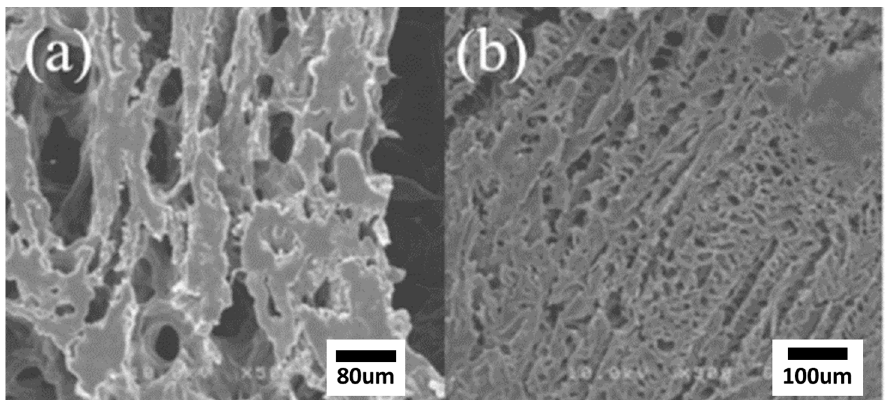
Figure 4. SEM of the edge of tablets removed from dissolution media (pH 6.8 phosphate buffer) after 1 h ( a ) Tablet with HPMC HME 4M ( b ) Tablet with HPC GXF. Tablet obtained after melt granulation of metformin HCl (75% w / w ) and HPMC HME 4M (25% w / w ) showed large pores which allowed faster release of drug from polymer matrix.